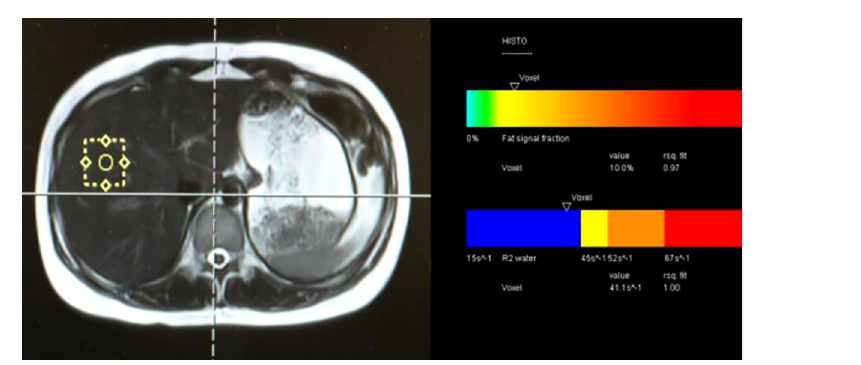
Fig 3. MRS-PDFF measurement on a volunteer with mild hepatic steatosis (MRS-PDFF =